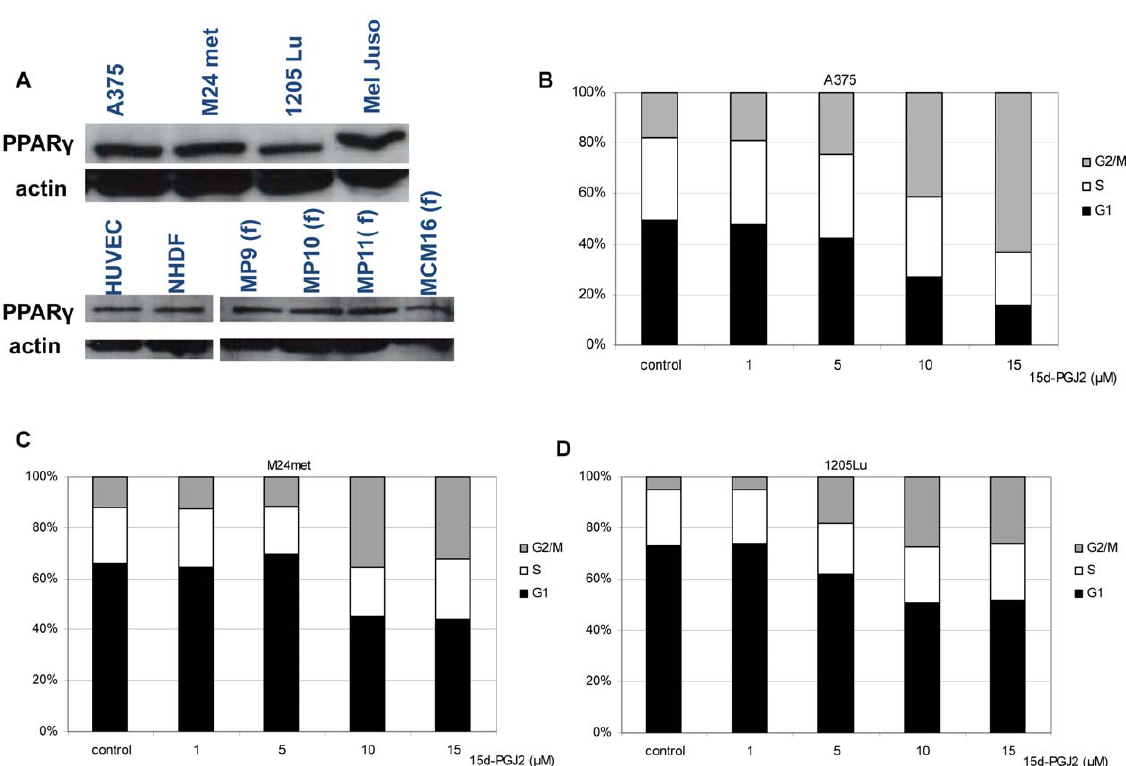
Figure 1. PPAR c receptor expression and G2/M arrest induction by 15d-PGJ2. A, receptor expression on A375, M24met, 1205Lu, MelJuso melanoma cells and HUVECs as well as fibroblasts NHDF and melanoma associated fibroblasts. (f): fibroblasts B, C ,D: Cell cycle analysis by flow cytometry using propidium iodide- stained on A375, M24met and 1205Lu. Cells were treated for 24 h with different concentrations of 15d-PGJ2. Three independent experiments were pooled and analyzed as a combined data set.